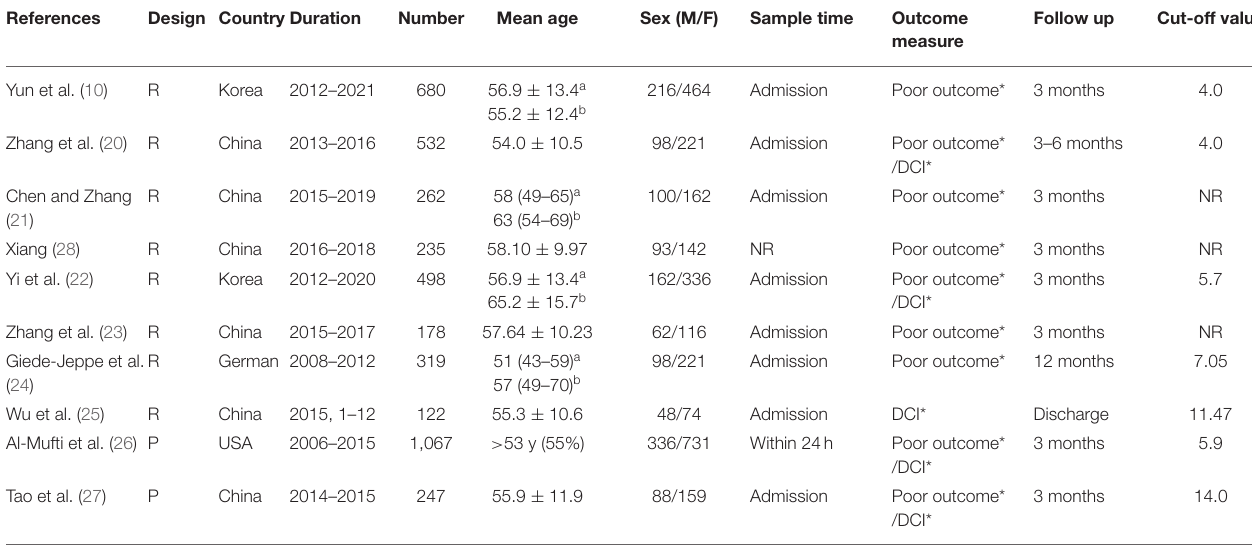
TABLE 1 | Baseline characteristics of the included